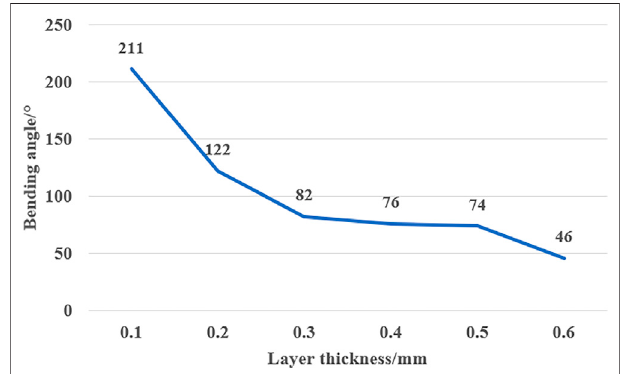
FIGURE 3 | Bending angles for different layer thicknesses.